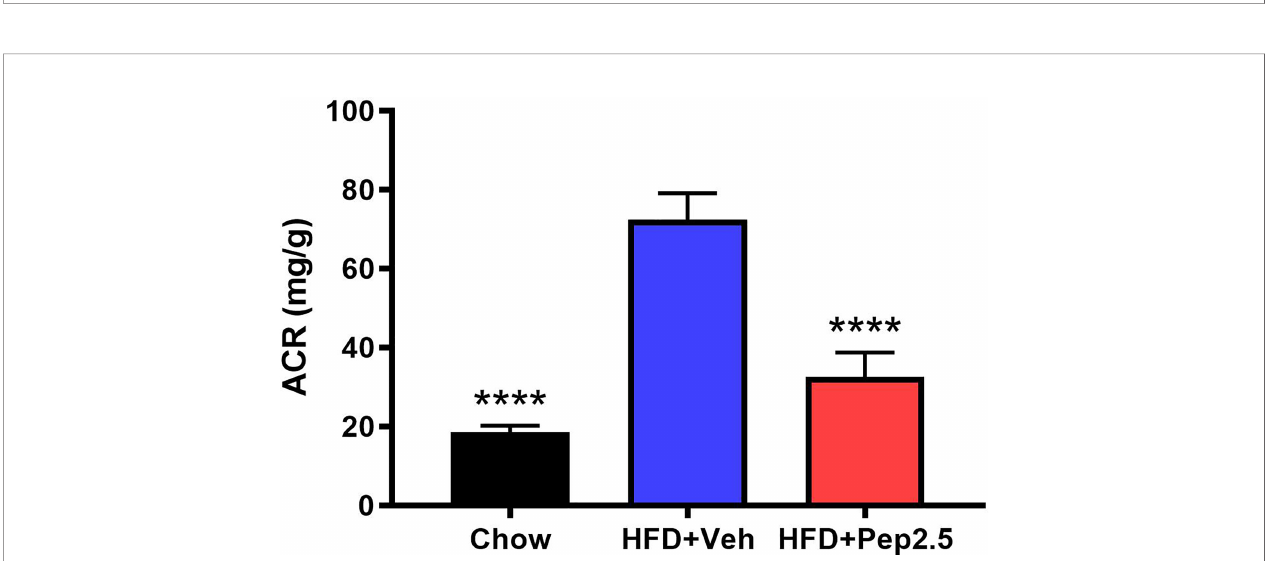
FIGURE 4 | Peptide 19-2.5 attenuates the development of microalbuminuria in HFD-fed mice. At week 12 urine was collected to calculate the albumin to creatinine ratio (ACR) (mg/dl). Data was analyzed by one-way ANOVA, with Bonferroni ’ s post-hoc test. Data are expressed as mean ± SEM; n = 10 per group. ****P < 0.0001 vs.